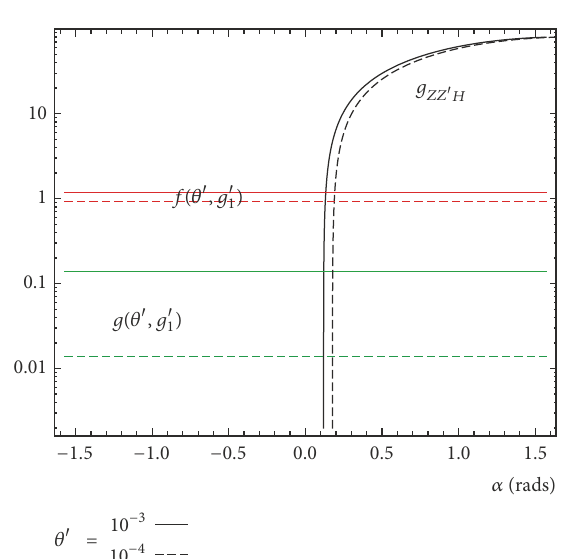
Figure 6: Same as in Figure 2, but for 𝑔 푍푍 󸀠 퐻 (𝜃 耠 , 𝑔 耠 1 ) , 𝑓(𝜃 耠 , 𝑔 耠 1 ) , and 𝑔(𝜃 耠 , 𝑔 耠 ) 1